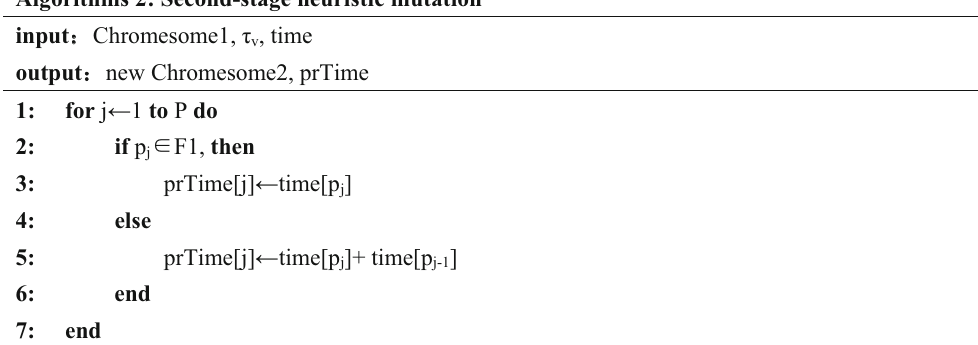
Algorithms 2: Second-stage heuristic mutation